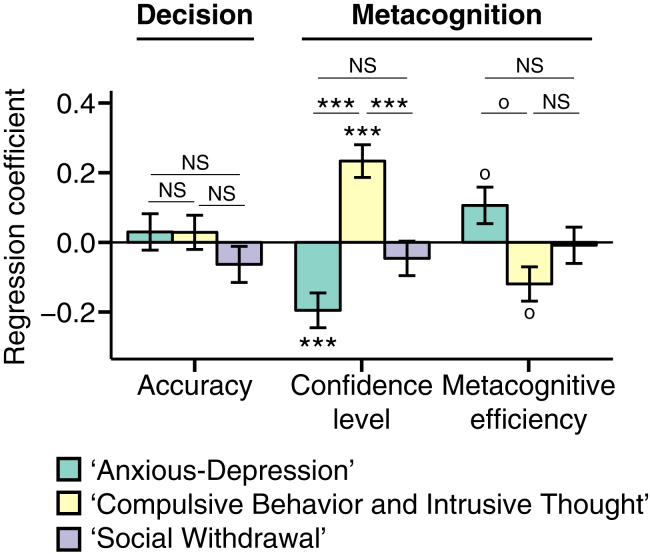
Factor analysis on the correlation matrix of 209 questionnaire items revealed a three-factor solution comprising anxious-depression, compulsive behavior and intrusive thought, and social withdrawal dimensions. Entry of these factors into a multiple regression model predicting decision formation and metacognition revealed bidirectional effects of anxious-depression and compulsive behavior and intrusive thought factors on confidence level, despite no relationships with performance. op < .05 uncorrected, ***p < .001 corrected for multiple comparisons over the number of dependent variables tested. See also Supplemental Figures S7C and S8. NS, not significant.